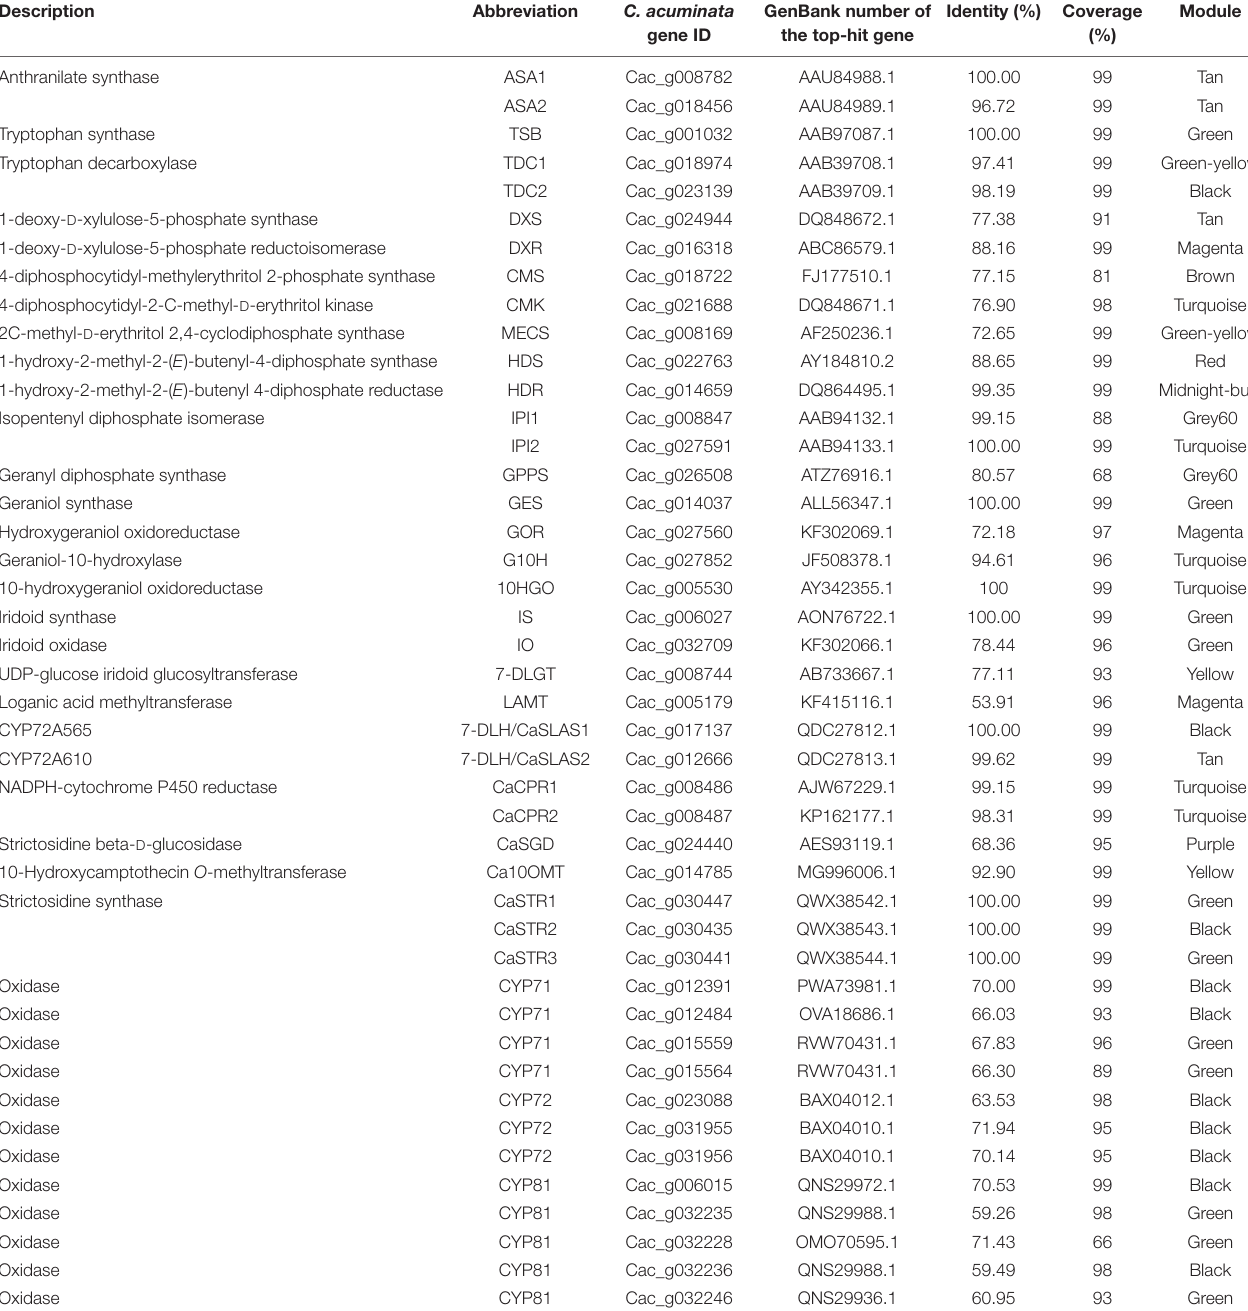
TABLE 4 | The characterized genes and the most probable CYP450 genes involved in camptothecin